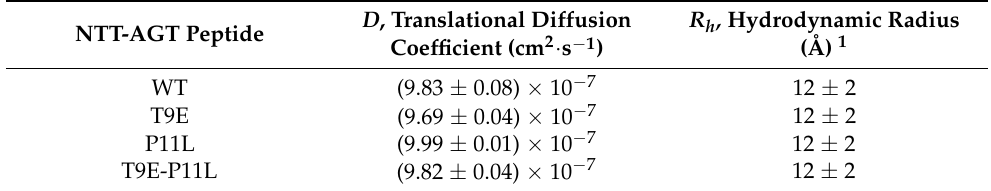
Figure 3. Summary of NMR data for the NTT-AGT peptides in aqueous solution and in 30% TFE (4.2 M). In every panel, NOEs are classified as strong, medium, or weak, according to the height of the bar underneath the sequence; signal intensity was judged by visual inspection from the NOESY experiments with 225 ms of mixing time. The corresponding H α NOEs with the following H α of a proline residue are indicated by an open bar in the row corresponding to the α N (i, i + 1) contacts. The dotted lines indicate NOE contacts that could not be unambiguously assigned, due to signal overlapping. Table 1. Self-association properties of the peptides in aqueous solution determined by translational diffusion